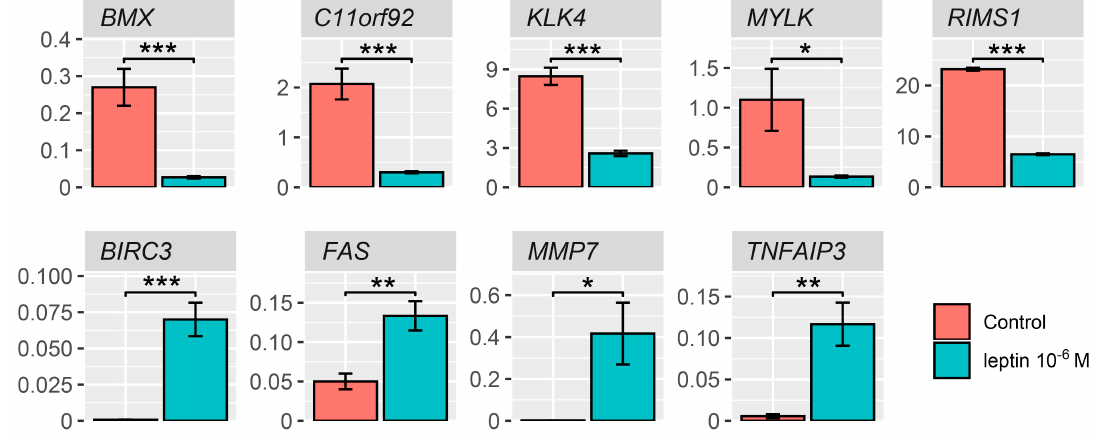
Figure 8. Real time qPCR validation of microarray data. BMX —BMX non-receptor tyrosine kinase, C11orf92 —chromosome 11 open reading frame 92, KLK4 —kallikrein-related peptidase 4, MYLK —myosin light chain kinase, RIMS1 —regulating synaptic membrane exocytosis 1, BIRC3 —baculoviral IAP repeat containing, FAS —apoptosis signal receptor / cell surface death receptor, MMP7 —matrix metallopeptidase 7, TNFAIP3 —tumor necrosis factor, alpha-induced protein 3. Results are presented as means ± SEM, n = 3. Statistical comparison by Student’s t-test: * p < 0.05; ** p < 0.02; *** p < 0.01.